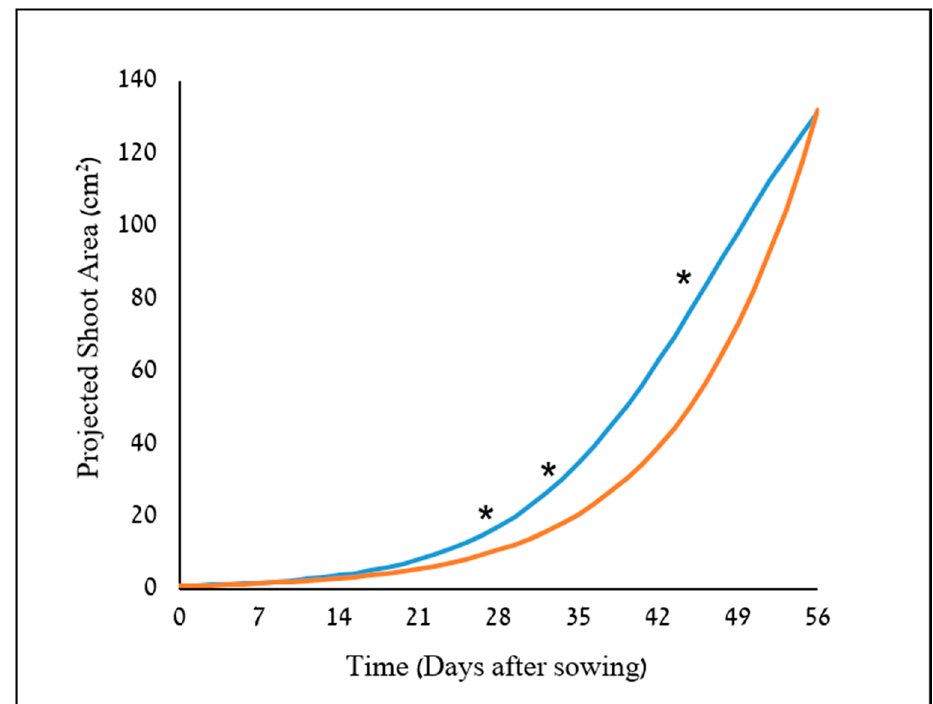
Figure 7. Sigmoid relationship between time (days after sowing) and X-1010 ( blue ) and triticale1 ( orange ) genotypes projected shoot area (PSA) values that were extracted from the 2-D model. Asterisks indicate a significant difference between X-1010 and Triticale1 ( p ≤ 0.05) according to the t -test ( n = 6).